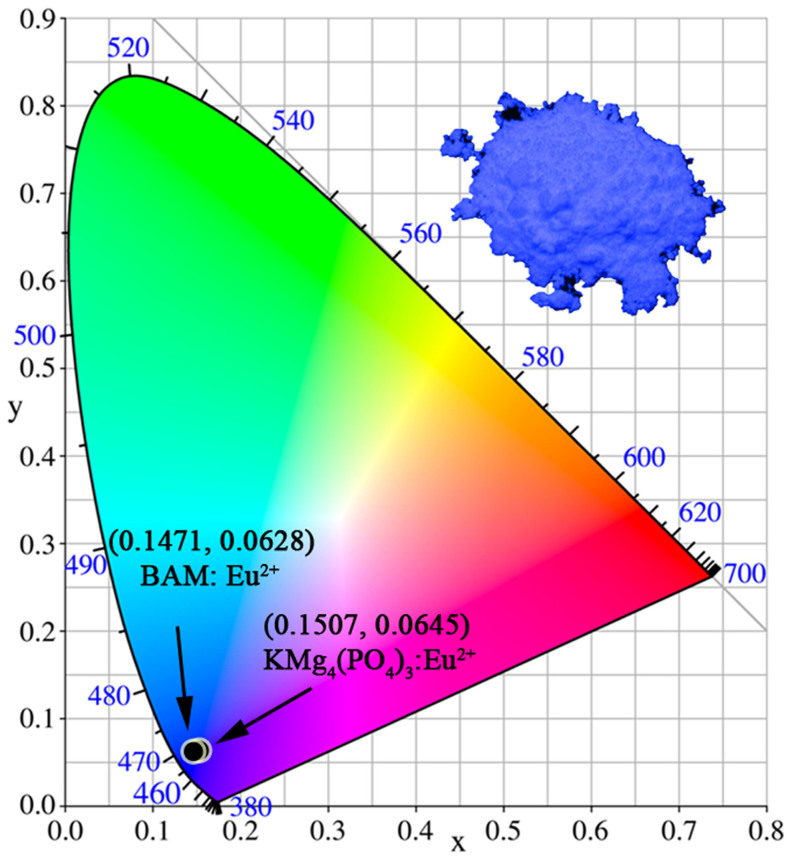
CIE coordinates of the KMg4(PO4)3:0.01Eu2+ phosphor and the commercial BAM:Eu2+.The inset shows a digital photograph of the blue-emitting KMg4(PO4)3:0.01Eu2+ sample.